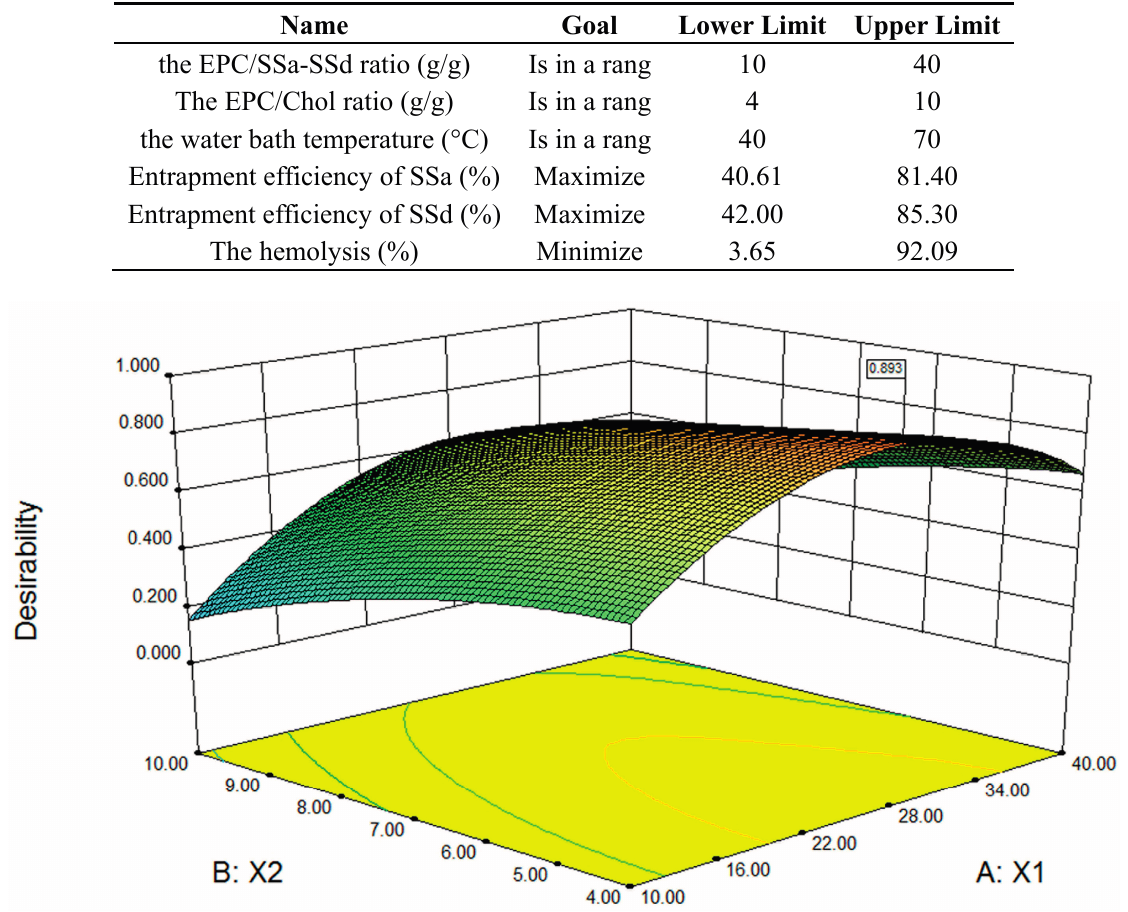
Table 7. Constraints of factors and responses for optimization.